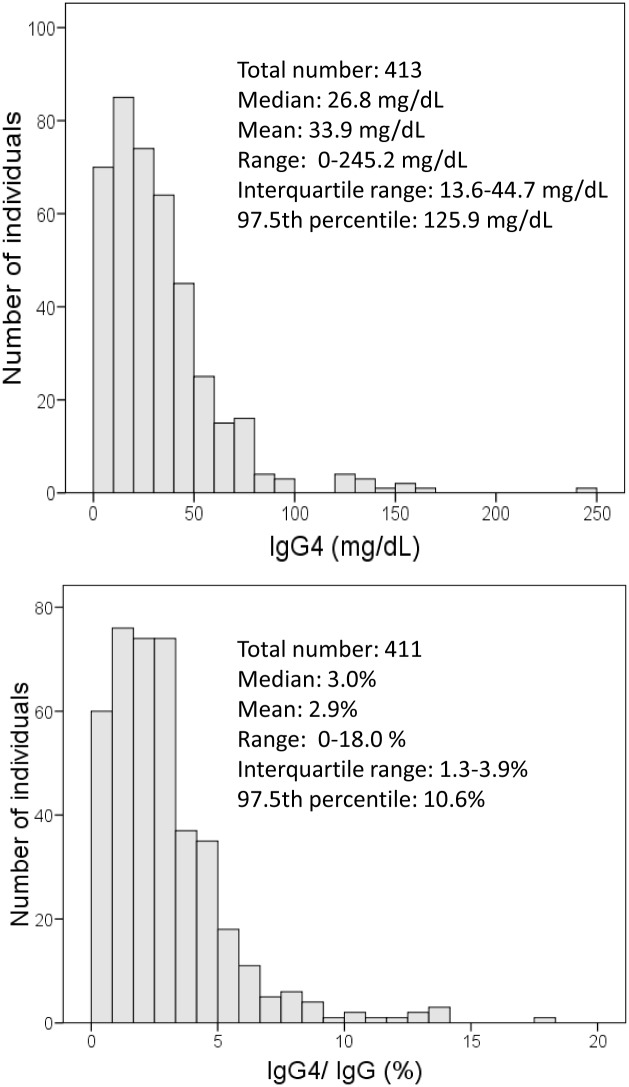
Histogram of serum igG4 concentrations and proportion of IgG4 over total IgG.Estimates (mean, median, and percentiles) were weighted according to the study design.